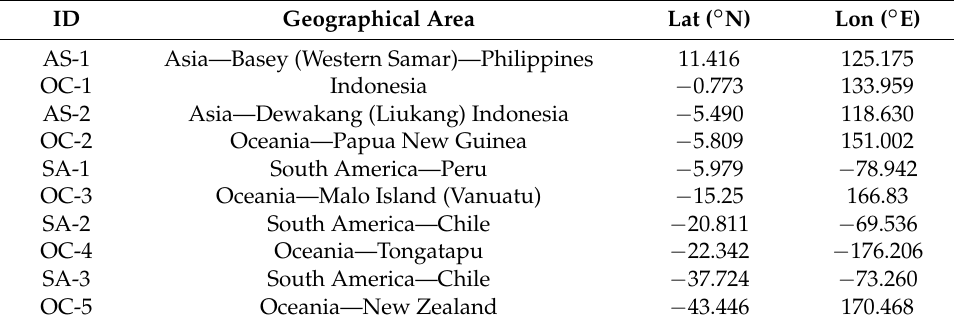
Table 2. Proposed ELF Observatories (1000 km).